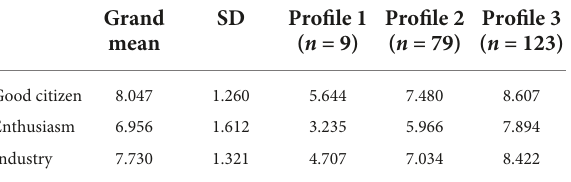
TABLE 2 Mean levels of role orientation factors in the three-latent-profile solution ( t 1